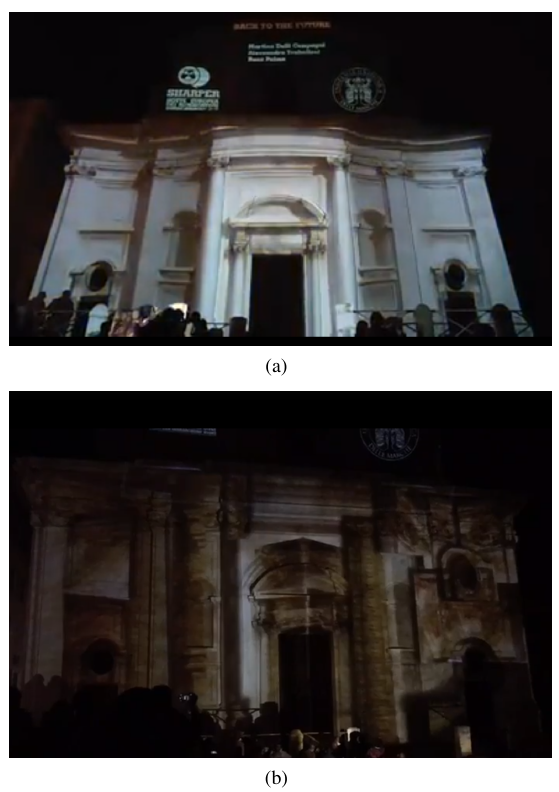
Figure 3. Two examples of storytelling that put in the center ar- chitecture itself: Back to the future Sharper 2016 (a), Art Attack Sharper 2017 (b)